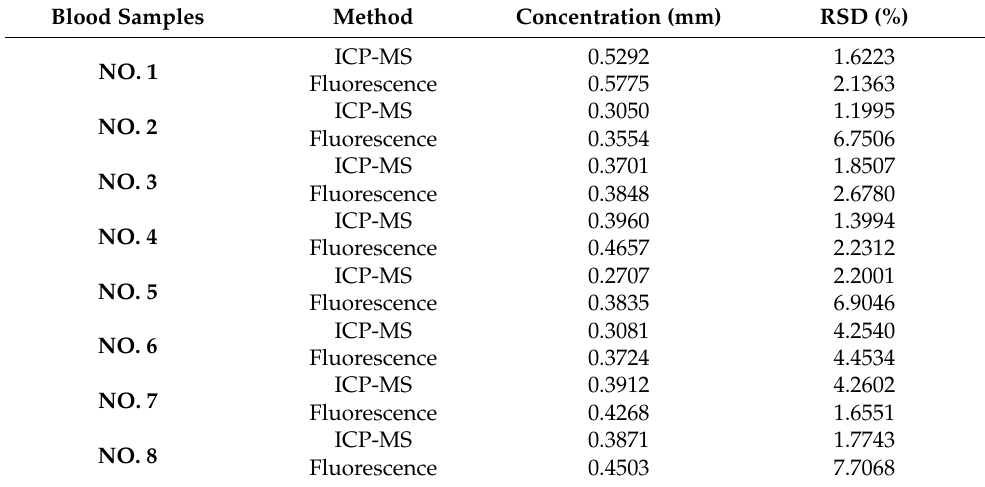
Figure 8. The Fe 3+ detection of blood samples by ICP-MS method and fluorescence method. Table 2. The Fe 3+ analysis of blood